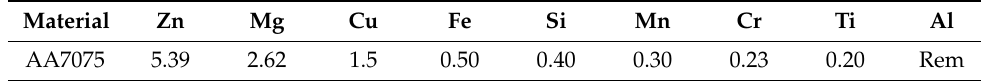
Table 1. Chemical compositions of AA7075-T6 aluminum alloy.